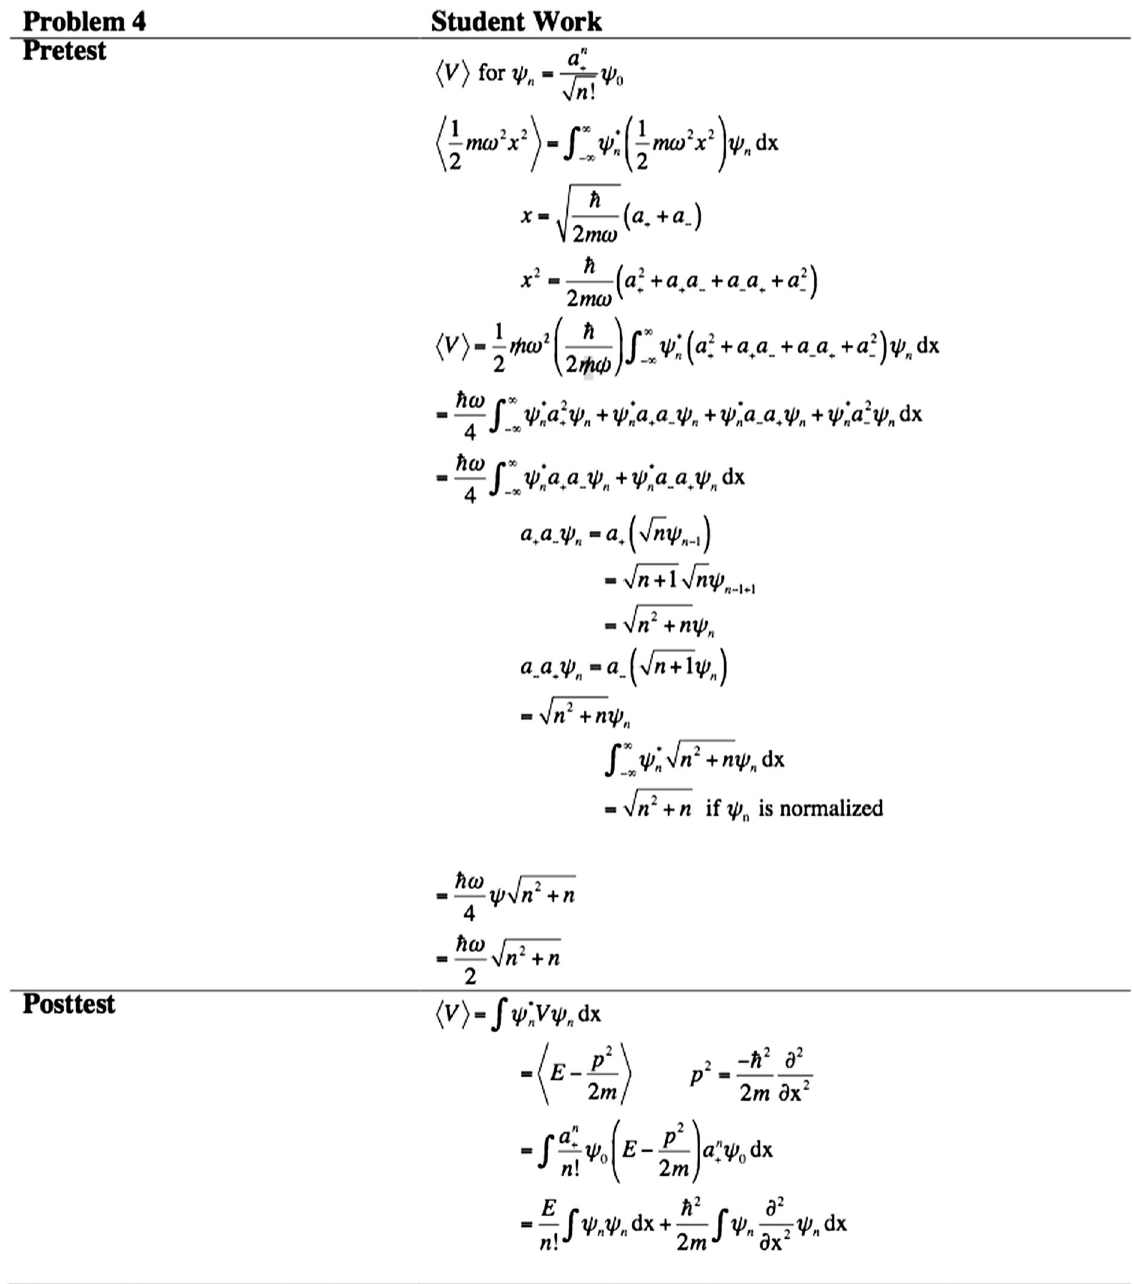
FIG. 6. An example of a pretest and posttest solution pair for a student from the comparison group which demonstrates a typical deterioration for the harmonic oscillator problem. The pretest and posttest scores are 100% and 40% for invoking, 83% and 0% for applying, and 92% and 20% for the overall scores, respectively. The student ’ s pretest performance is good, except for some minor errors with the coefficients when dealing with the ladder operators but the posttest solution demonstrates that this proficiency has